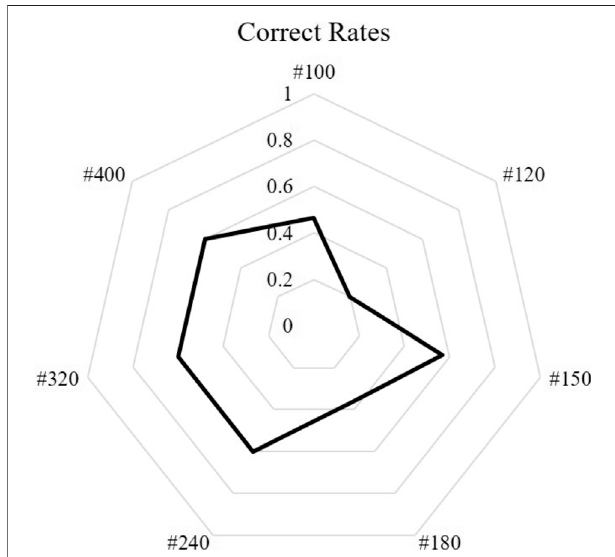
FIGURE12| Correct ratesfrom thediscrimination experiment using real